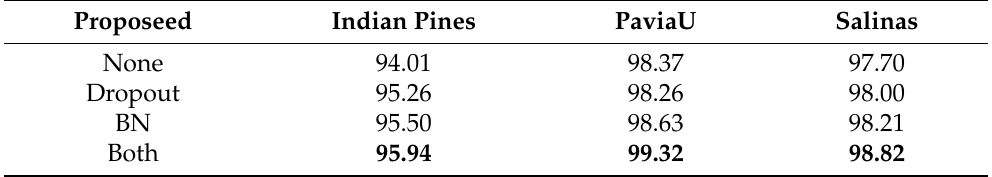
Table 5. Network regularization method in the Indian Pines, PaviaU, and Salinas data sets. Proposeed